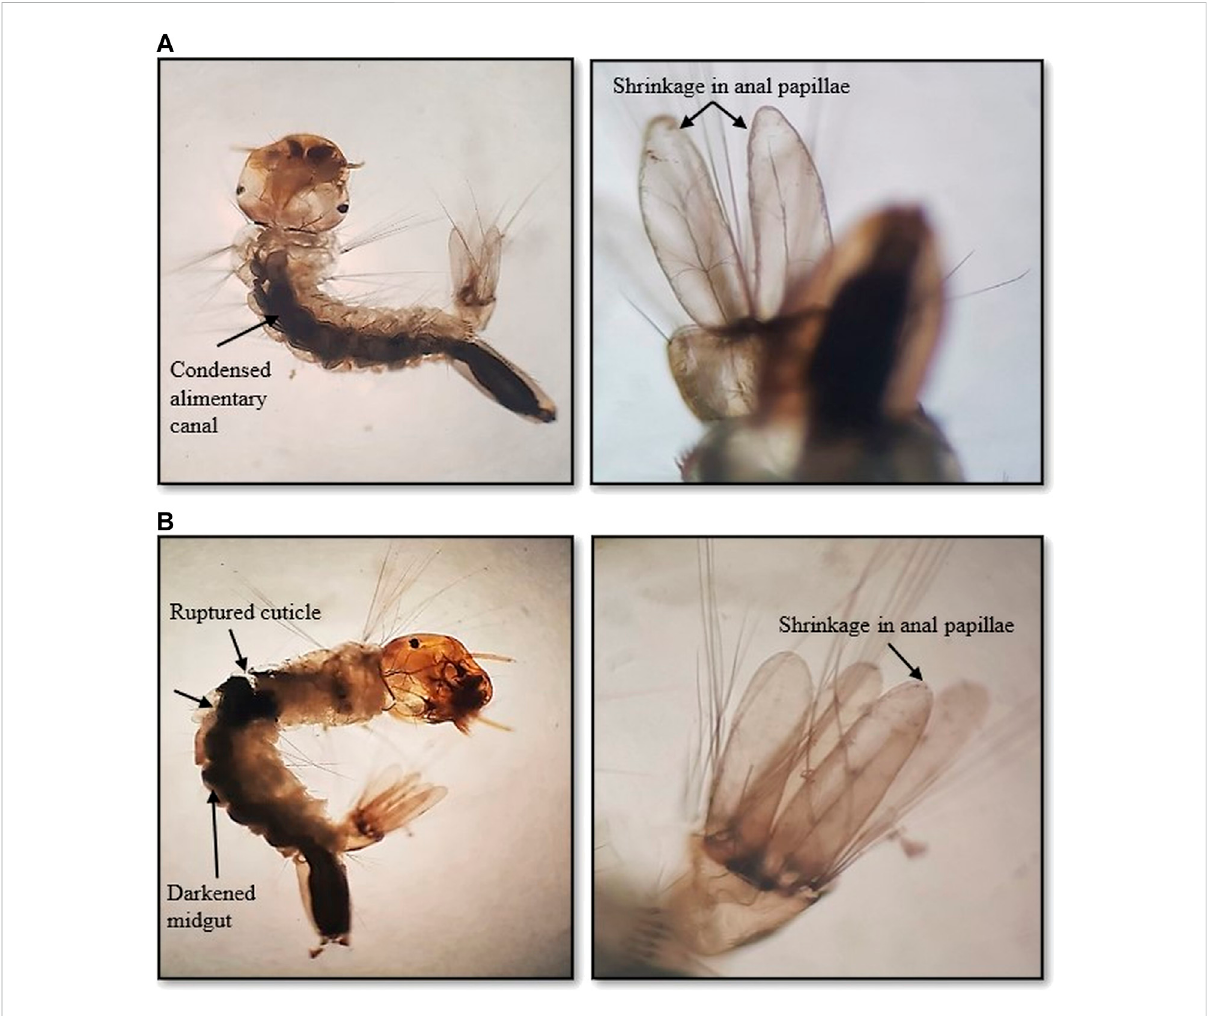
FIGURE 2 Light photomicrographs of early fourth instars of Aedes aegypti with an enlarged view of mid-gut and anal papillae on exposure to (A) Achyranthes aspera leaf extract-mediated silver nanocomposites (AL-AgNCs) and (B) Achyranthes aspera stem extract-mediated silver nanocomposites (AS-AgNCs) ( → ) indicates damaged area showing high pigmentation and blackening of the mid-gut region, ruptured cuticle, and deformed body with shrinkage in anal